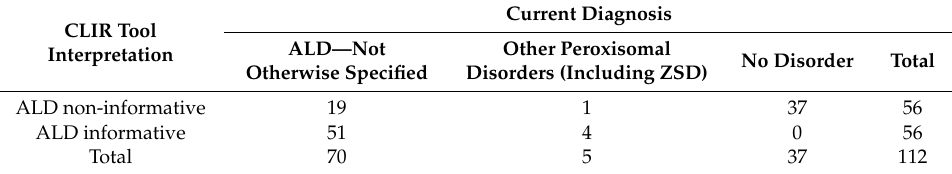
Table2. ComparisonofCLIRtoolALDinterpretationwithcurrentdiagnosisforallALDscreenpositives. CLIR Tool